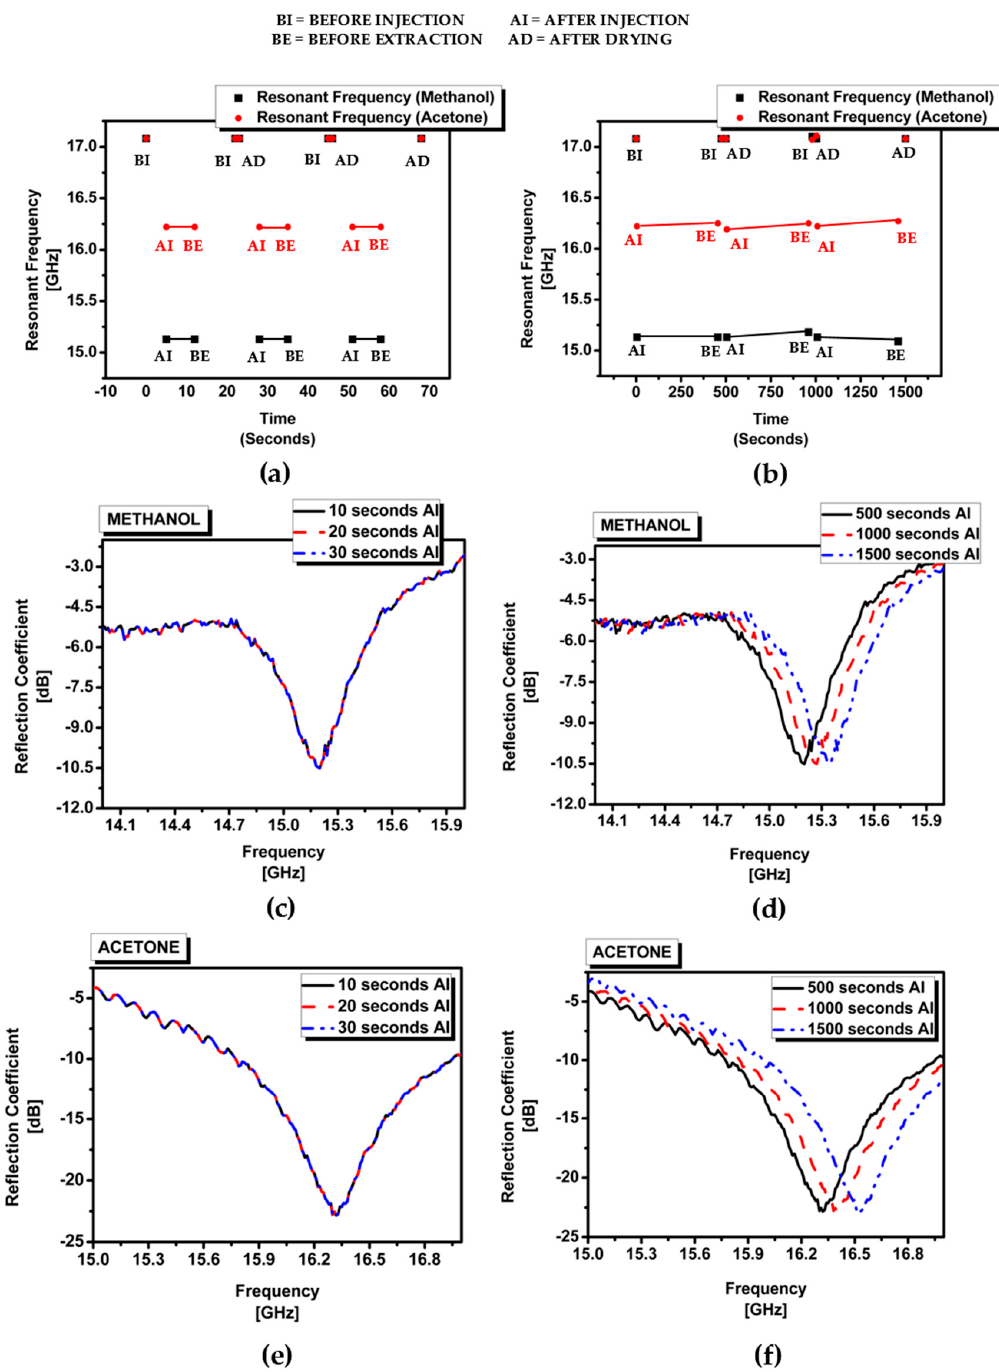
Figure 8. Repeatability test of the proposed SIW chemical sensor for methanol and acetone: ( a ) frequency variation of test #1 (fast injection and extraction process); ( b ) frequency variation of test #2 (slow injection and extraction process); ( c ) measured reflection coefficients of test #1 with methanol; ( d ) measured reflection coefficients of test #2 with methanol; ( e ) measured reflection coefficients of test #1 with acetone; ( f ) measured reflection coefficients of test #2 with acetone.